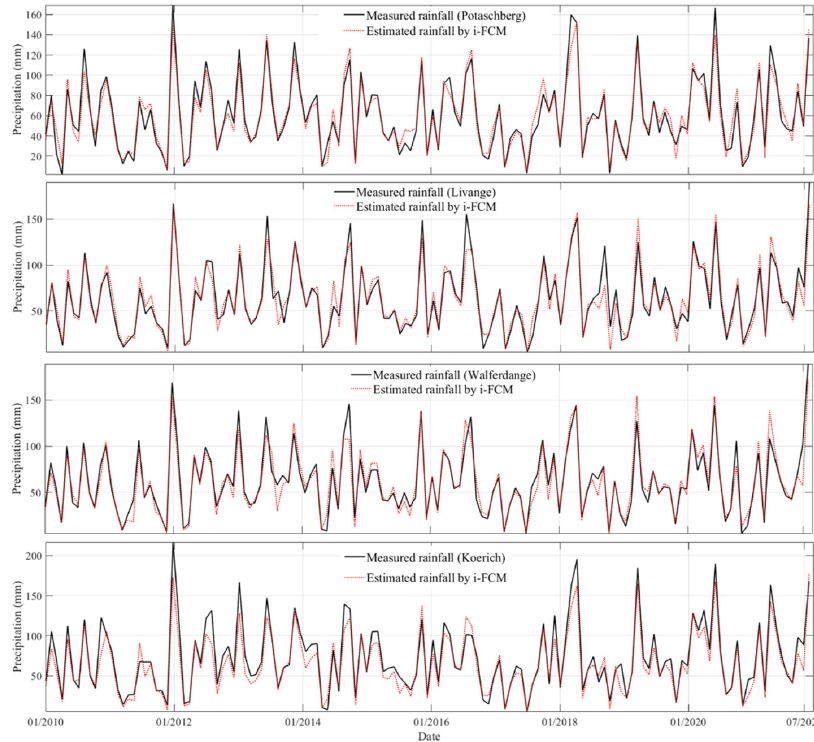
Figure 8. Measured and estimated monthly rainfall data in validation stations.